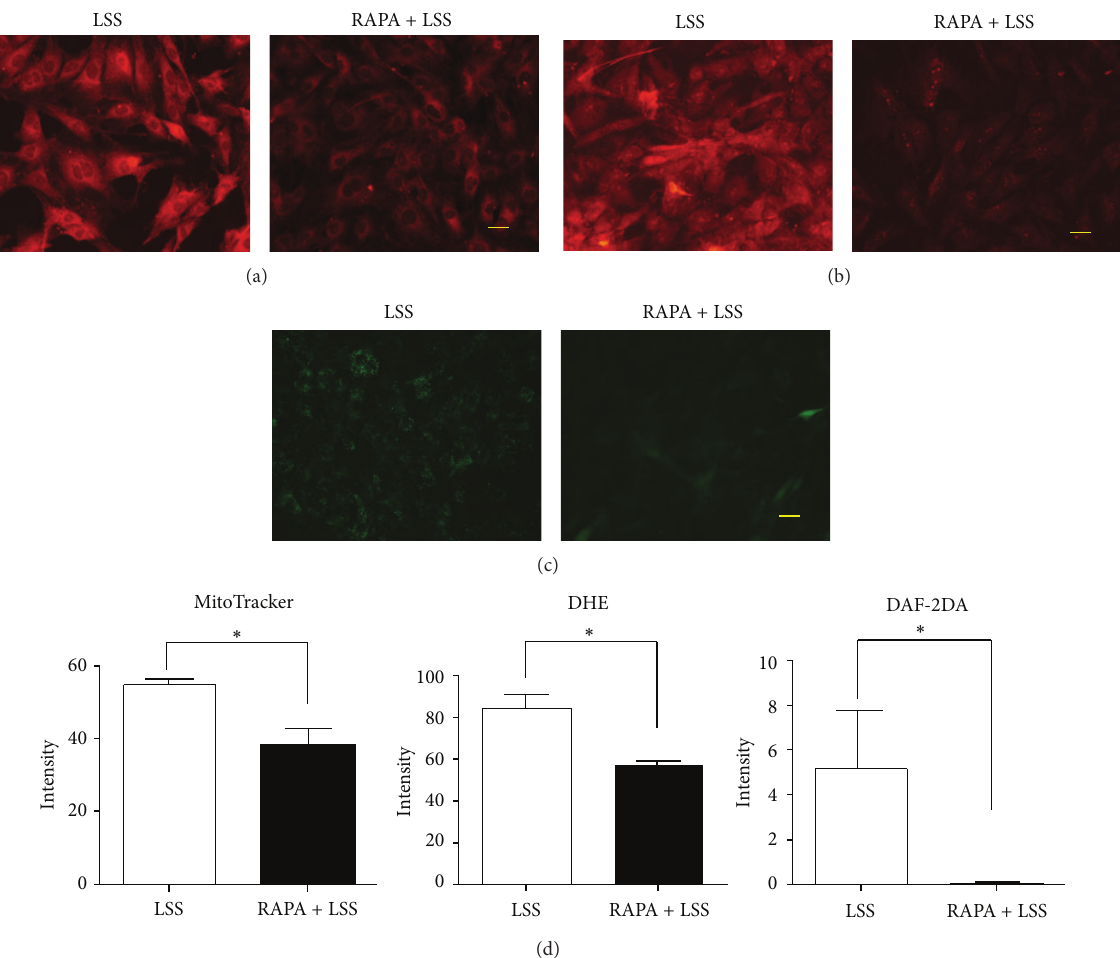
Figure 3: Rapamycin attenuated LSS induced ROS/RNS production in RAECs. ROS/RNS accumulation caused by LSS at 2 dyne/cm 2 was attenuated by rapamycin (RAPA) at the concentration of 100 ng/mL in RAECs. (a) RAPA ameliorated the effect of LSS on promoting ROS production examined by mitoTracker. (b) Consistent result was observed with DHE staining. (c) Rapamycin attenuated LSS induced RNS accumulation assayed by DAF-2DA. Scale bars: 25 𝜇 m ((a)–(c)). (d) The column graphs demonstrated the fluorescence intensity and size was significantly reduced in RAPA + LSS group as compared with LSS group, 𝑃 < 0.05 , 𝑛 = 4